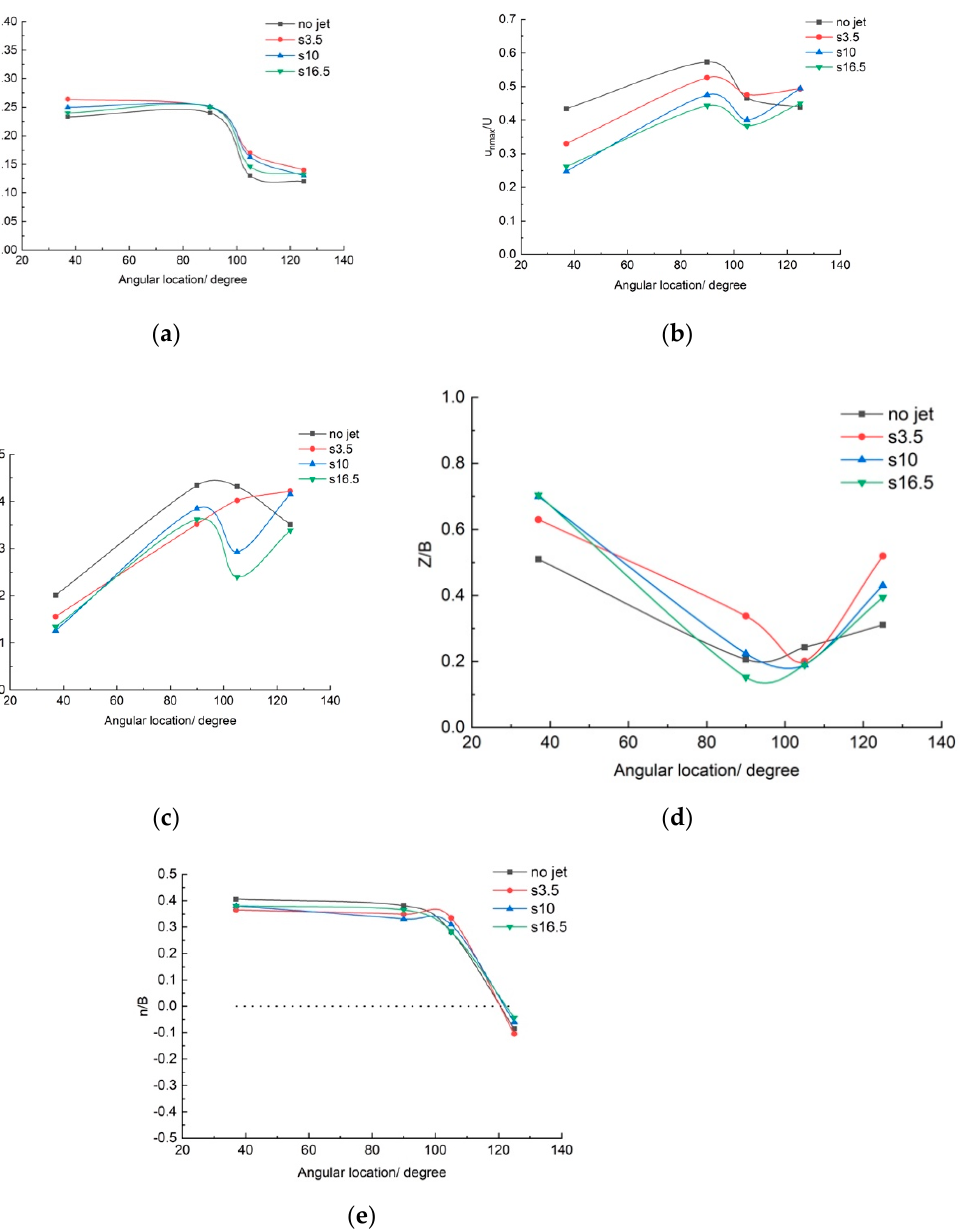
Figure 5. Dimensionless maximum velocities proceed at the bend with different jet conditions: ( a ) streamwise velocity; ( b ) transverse velocity; ( c ) vertical velocity; ( d ) evolution of the maximum streamwise velocity in the vertical direction; ( e ) evolution of the maximum streamwise velocity in the transverse direction.